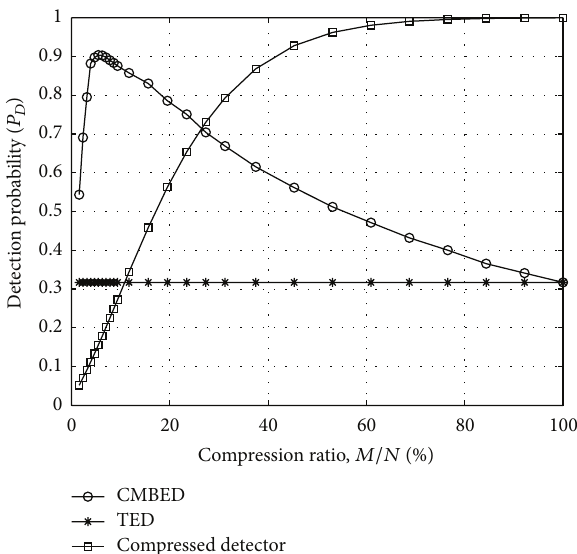
Figure 5: Probability of detection versus the compression ratio when 𝑃 𝐹 = 0.01 , 𝑁 = 128 , and 𝛾 = 15 dB.